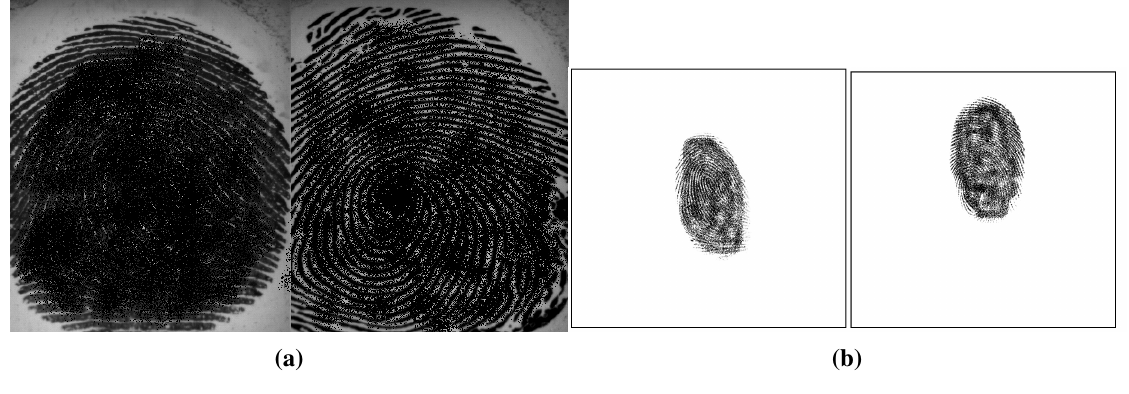
Figure 3. Example of differences in background area in two pairs of real and fake fingerprint images from two different datasets (images were degraded for privacy purposes). ( a ) Pair of real and fake fingerprint images with a small area of background (Biometrika dataset); ( b ) Pair of real and fake fingerprint images with a significant area of background (Crossmatch